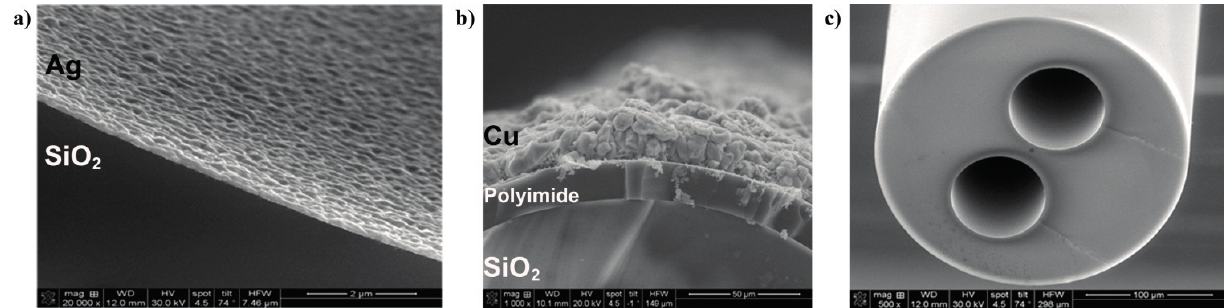
Figure 4. SEM pictures of the ( a ) LCX inner silver thin film lining; ( b ) LCX outer copper thin film lining; ( c ) 75µm-diameter dual-core fiber